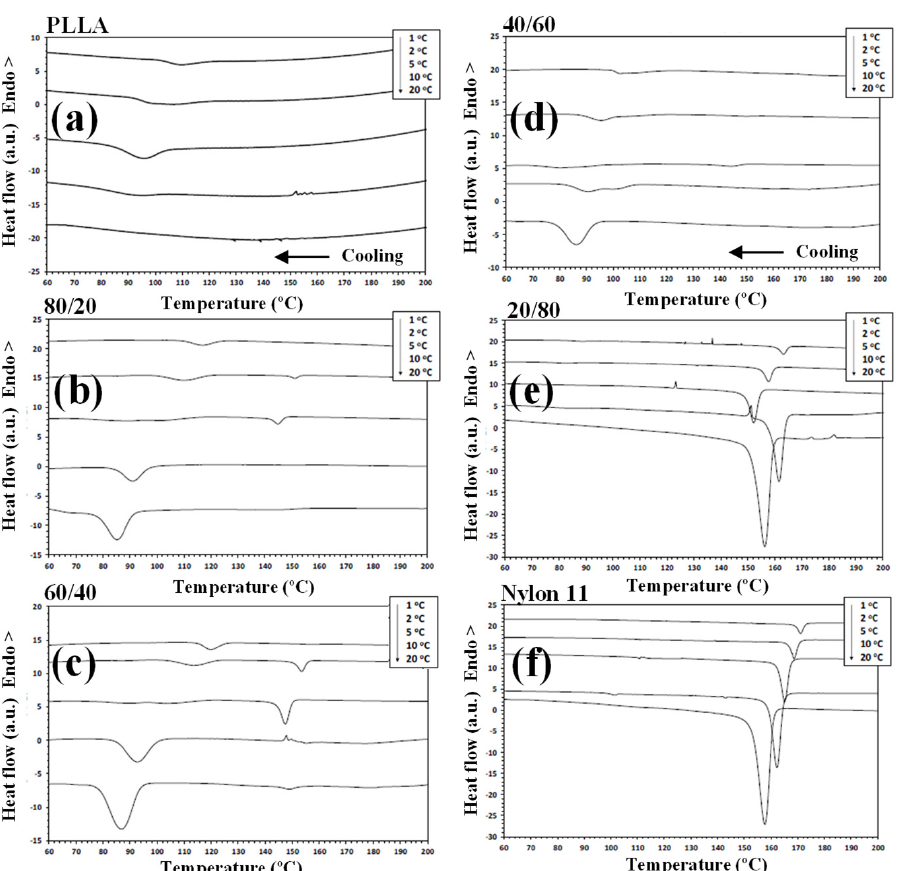
Figure 3. Non-isothermal crystallization DSC thermograms for PLLA, nylon 11 and PLLA/nylon 11 blends at the cooling rates indicated: ( a ) PLLA; ( b ) PLLA/nylon 11 (80/20); ( c ) PLLA/nylon 11 (60/40); ( d ) PLLA/nylon 11 (40/60); ( e ) PLLA/nylon 11 (20/80); ( f ) nylon 11.